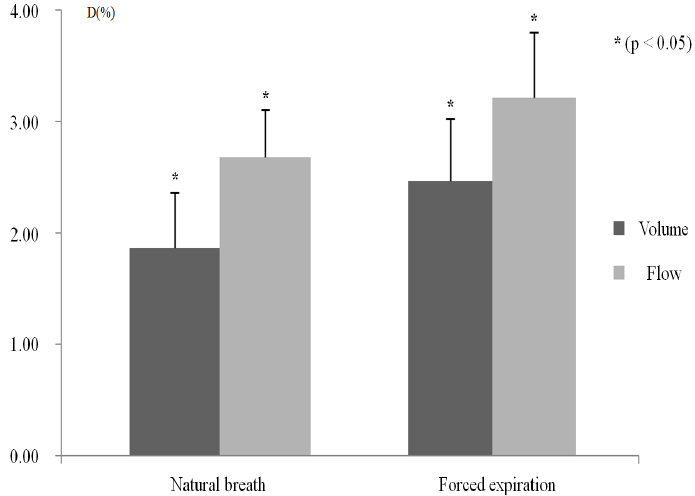
) and forced expiration (PFT) for all T